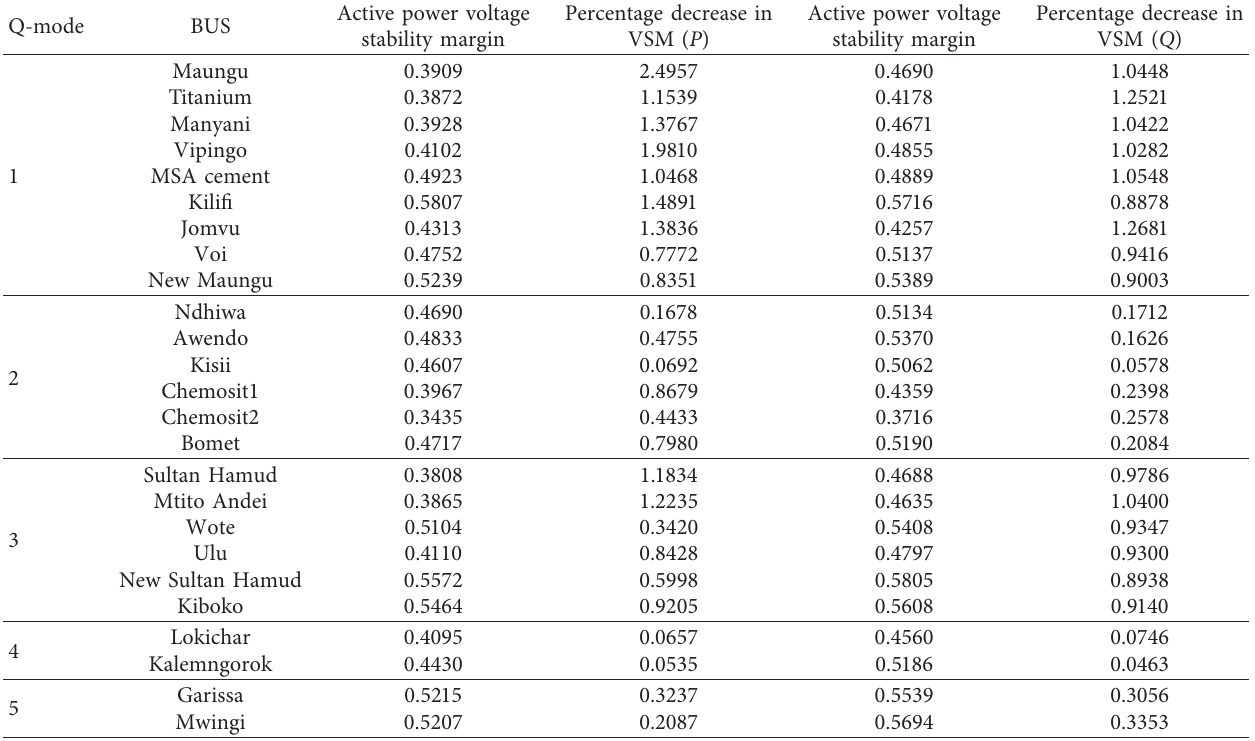
Table 8: Voltage stability margins of the selected load buses in critical Q-Modes after removal of the line.